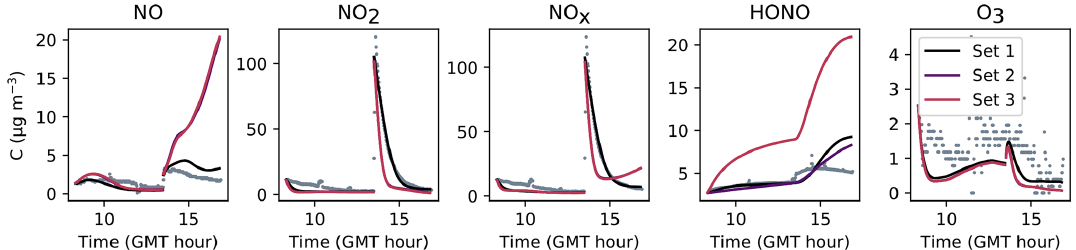
Figure 7. Simulation of Experiment 1 for the three sets of parameters. The dots denote the experimental records. The concentrations simulated in the sunlit box (solid lines) and the concentrations simulated in the shaded box (dashed lines) are superimposed.